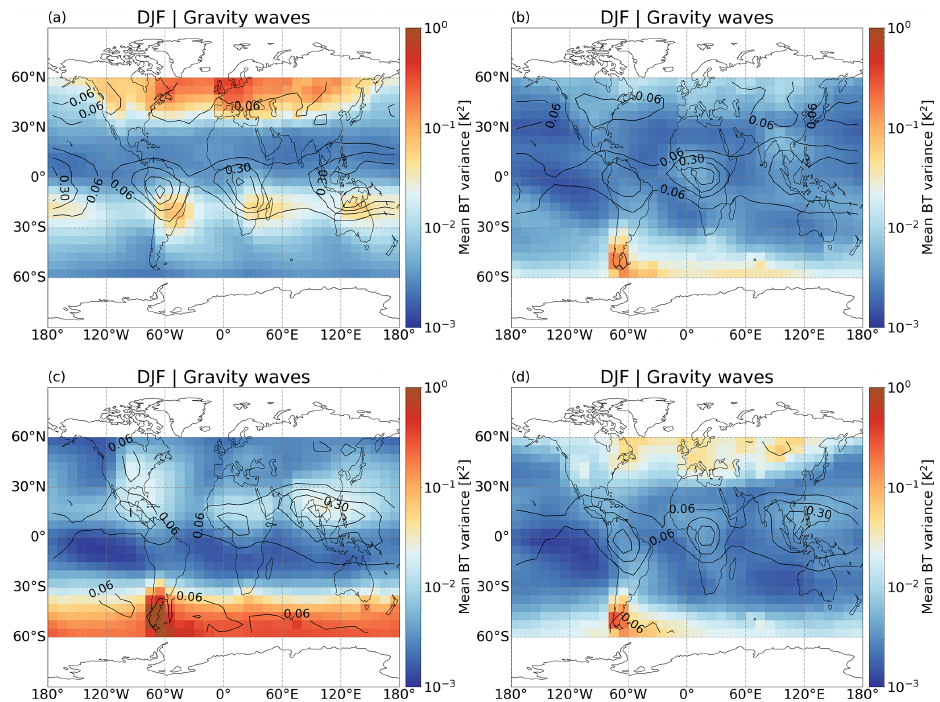
Figure 7. Mean brightness temperature variance at 4.3µm from AIRS measurements, which correlates with the amplitude of gravity waves. Black contours are the occurrence frequencies of SICs, as shown in Fig. 1a–d.